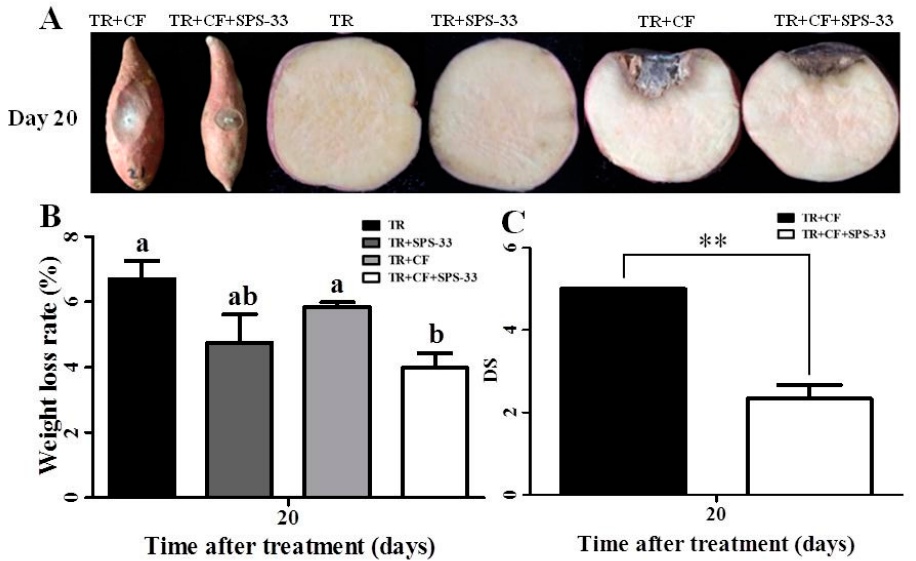
Figure 3. Fumigant effects of SPS-33 in sweet potato TRs. ( A ) Inhibition of black spot disease development in sweet potato TRs. ( B ) Weight loss rate of sweet potato TRs. Means with different letters denote significant differences ( P < 0.05). ( C ) DS of sweet potato TRs. **denotes significance at P <0.01. TR, tuberous root. CF: C. fimbriata . DS: disease severity.